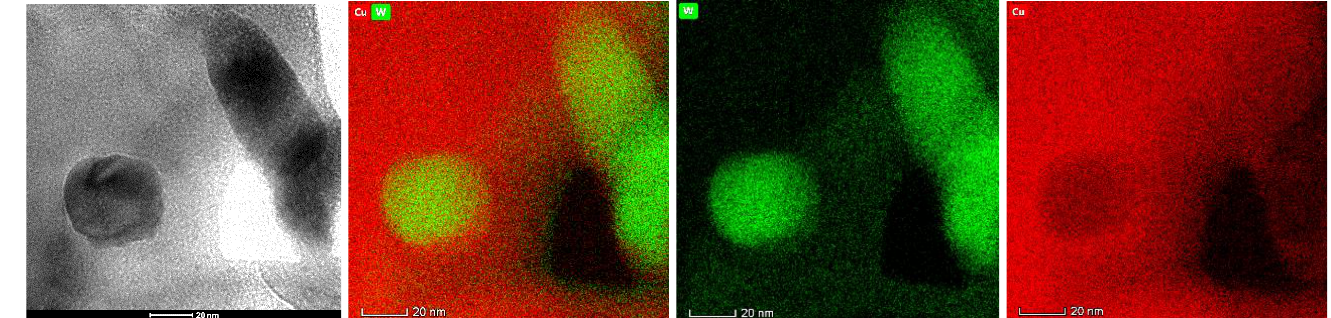
Figure 9. TEM image and EDS maps of W – Cu composite ( J = 2 A/dm 2 , f = 1500 Hz, d f = 40% and d r = 10%).